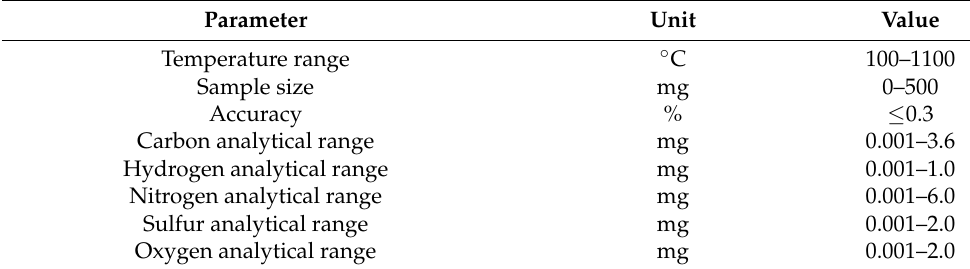
Table 5. Technical specifications of the PerkinElmer CHNS/0 2400